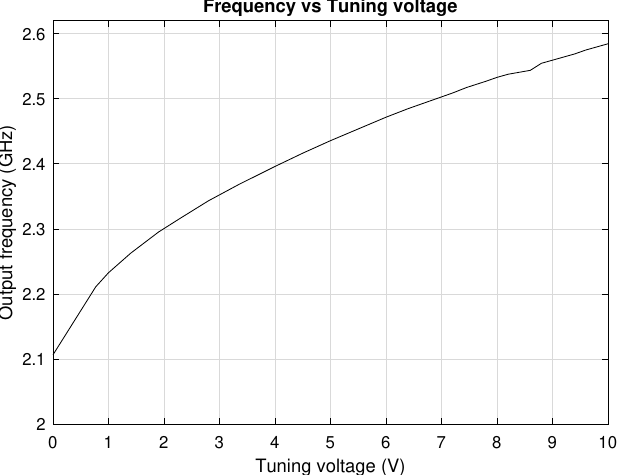
Figure 6. Relation between Vtune and Oscillation Frequency.